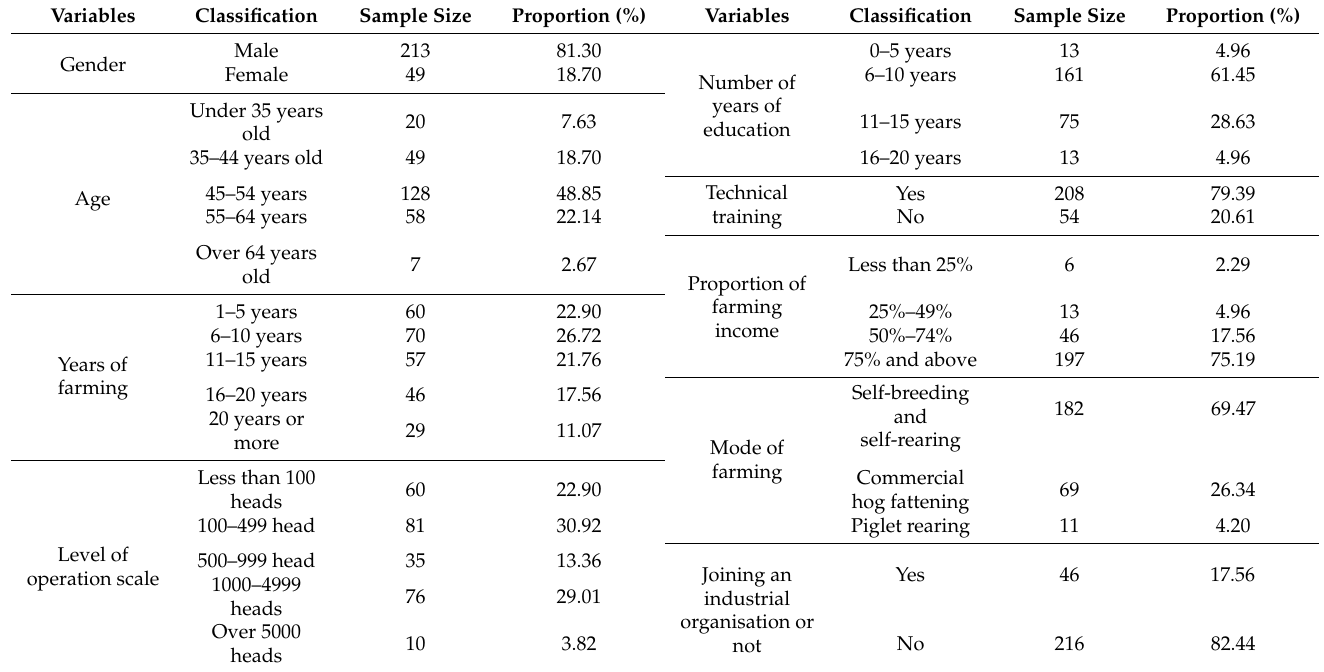
Table 3. Basic characteristics of the survey sample